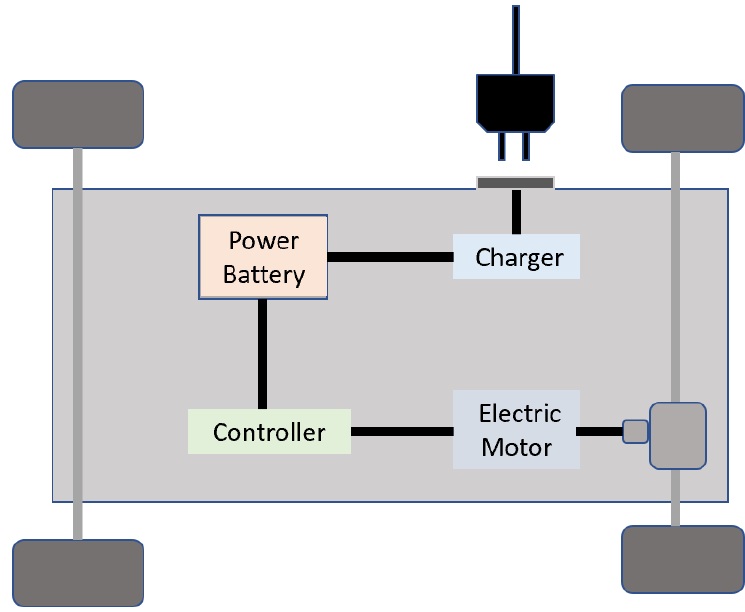
Figure 1. Simple design of a BEV.